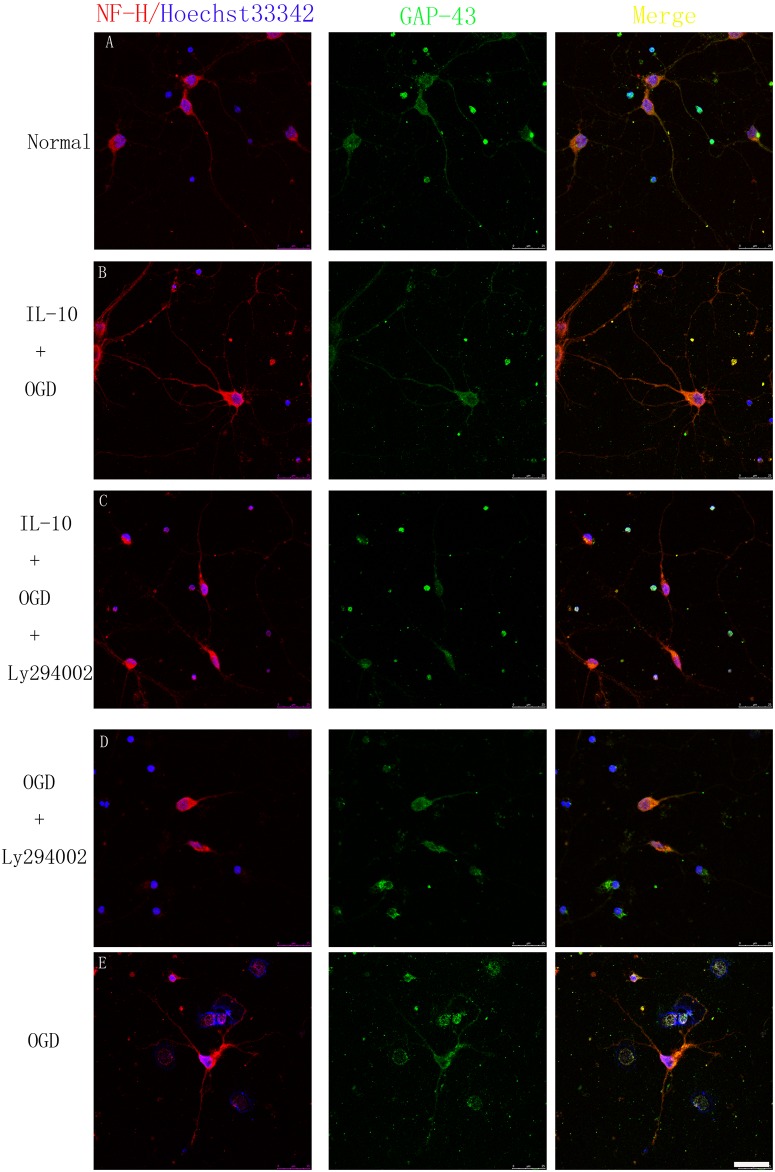
Effect of IL-10 on axons and dendrites.The left column displays neuronal marker NF-H (red) and nucleus (blue). The length of the axons and the numbers of the dendrites were clearly shown. The middle column displays the expression of GAP-43 (green), which is expressed in the somas, axons and dendrites. The right column shows GAP-43 mainly located in the proximal axons (yellow).